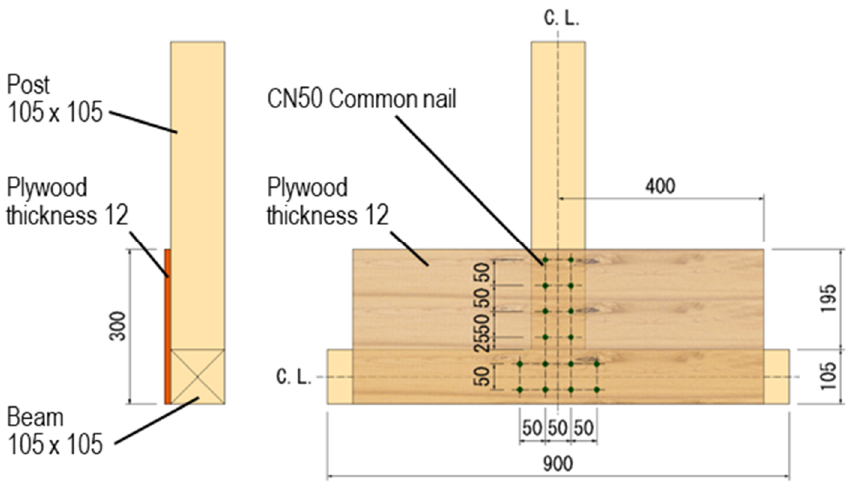
Figure 4. Details of P and N pullout test specimen; dimensions in mm.